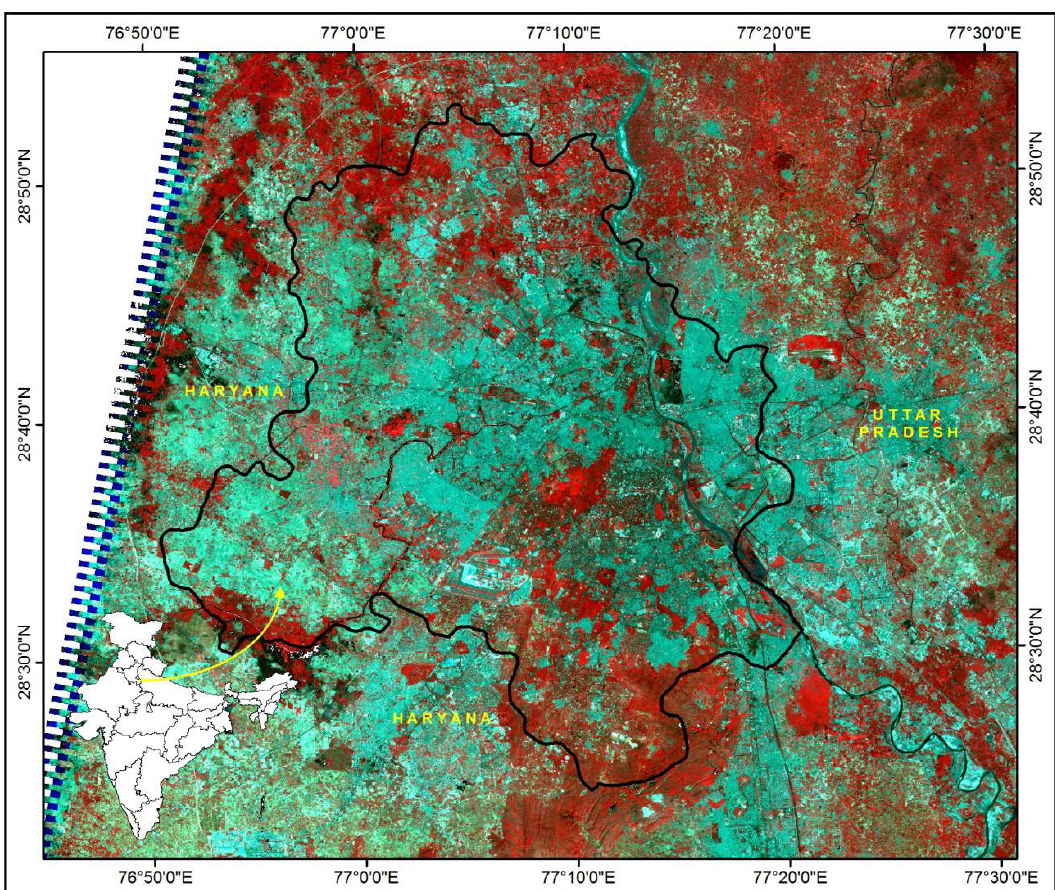
Figure 1. Location of study area on Landsat Thematic Mapper (TM) 5 satellite image in India. The red color represent vegetation surface, sky blue the urban and rural built-up area, pink-grey-cyan agriculture, dark blue-grayish blue-black the water and river, light sky blue the